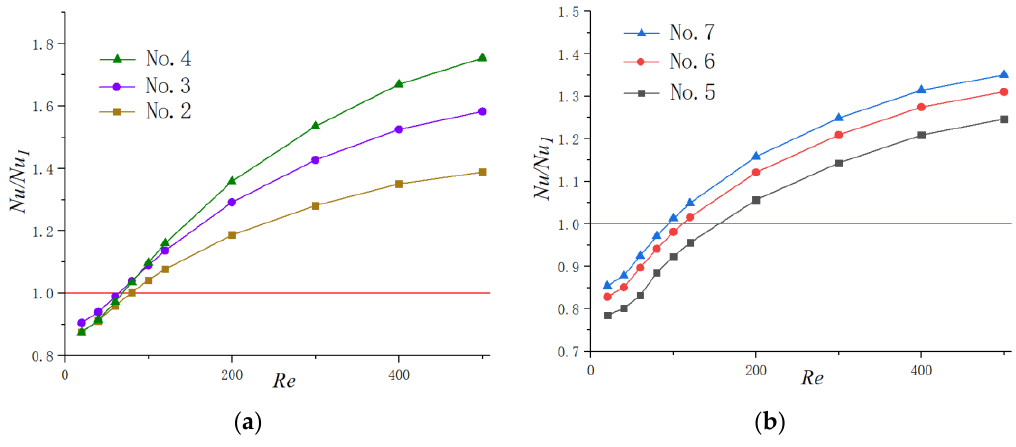
Figure 8. Variation of 𝑁𝑢/𝑁𝑢 1 with Re. ( a ) Group 1, ( b ) Group 2.